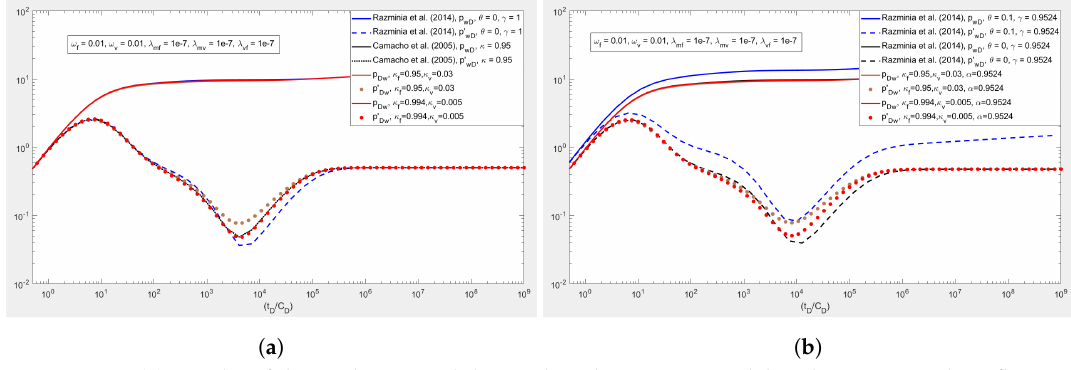
Figure 2. ( a ) Results of the triple permeability and triple porosity model with non-anomalous flow. ( b ) Results of the triple permeability and triple porosity model with anomalous